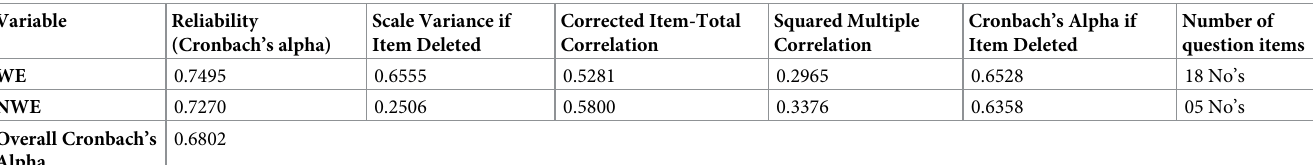
Table 2. Cronbach’s alpha value–on independent